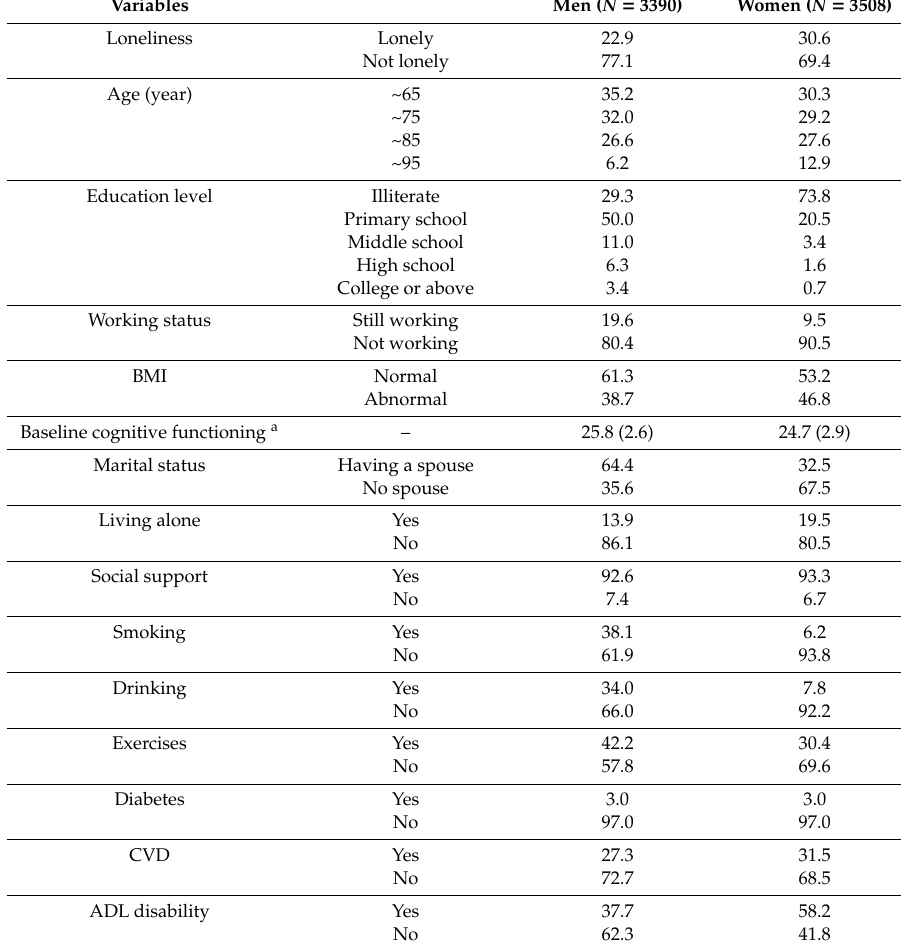
Table 1. Baseline characteristics of the study sample ( N = 6898;